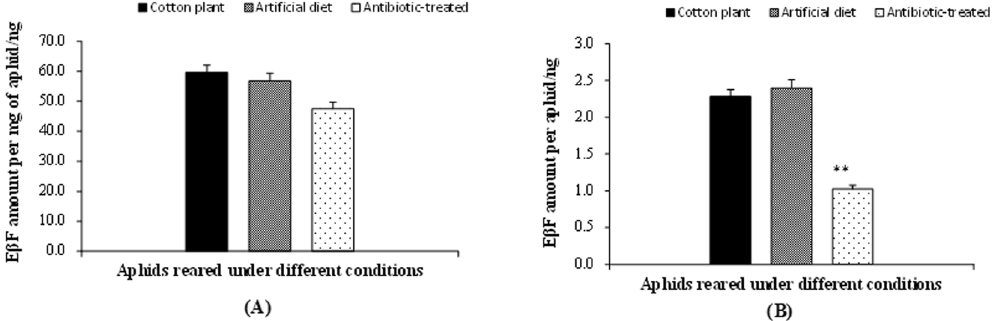
Figure 3. Amount of E β F per mg of aphid ( A ) and per aphid ( B ) under different